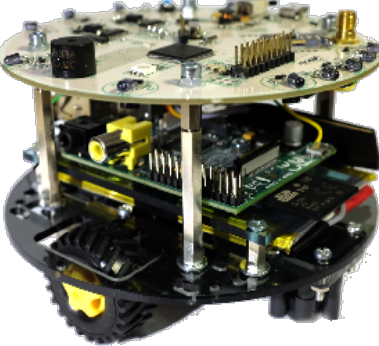
Figure 3: Research mobile